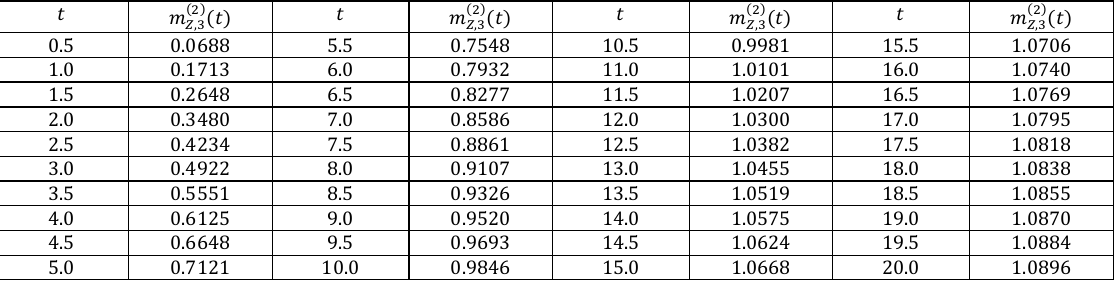
Table 6. Environment level 3 dependent growth of maligant cells (Two mutation)